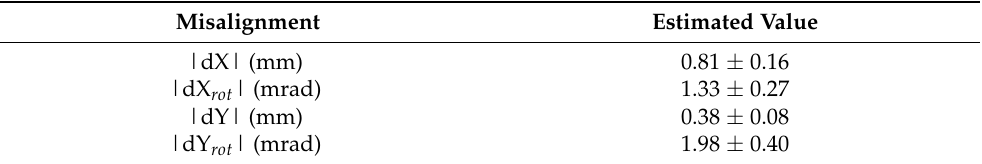
Table 3. Results for the solenoid misalignment obtained for both polarity settings (++, + − ) and two RF powers (3.6MW and 2.6MW) from the beam-based alignment